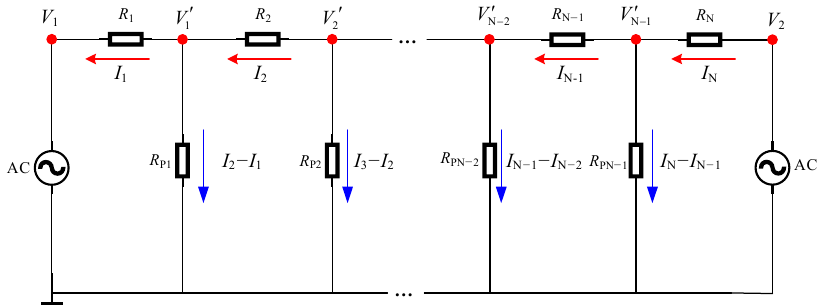
The resistance of the capacitive reactance in parallel with the resistance of the LC material can be expressed as R Pn = X Cn R LCn / ( X Cn + R LCn ) . Then, the circuit in Figure 5 can be further simplified into Figure 6.